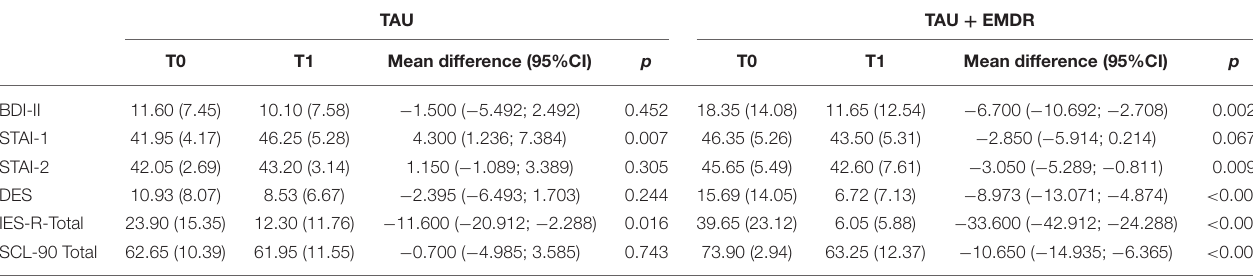
TABLE 3 | Comparison between T0 and T1 of clinical variables for the two groups (TAU and TAU + EMDR). TAU TAU + EMDR T0